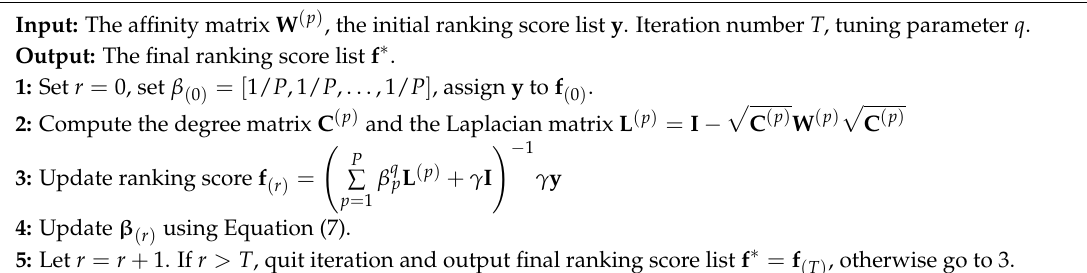
Algorithm 1. Solution to the retrieval